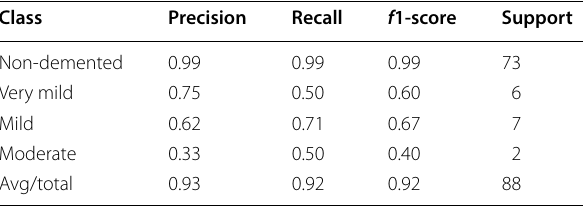
Table 1 Classification performance of M 1